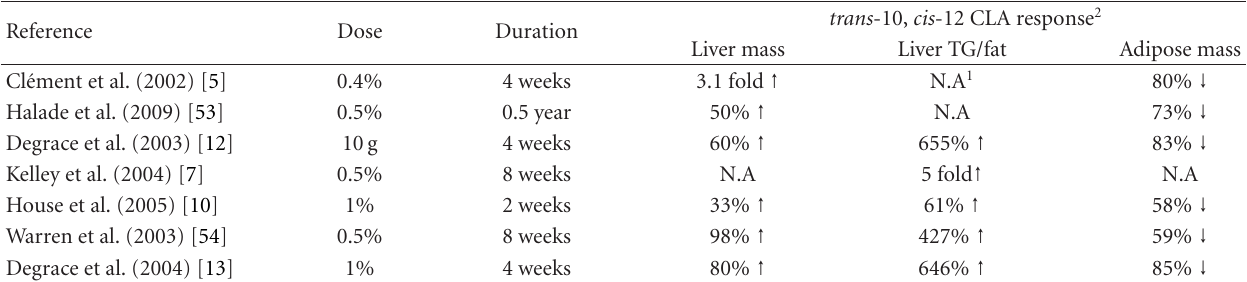
Table 1: Summary of the changes in liver mass, liver TG, and adipose tissue mass observed in previous mouse studies feeding di ff erent levels of trans -10, cis -12-CLA compared with feeding linoleic acid (LA) or oleic acid (as canola